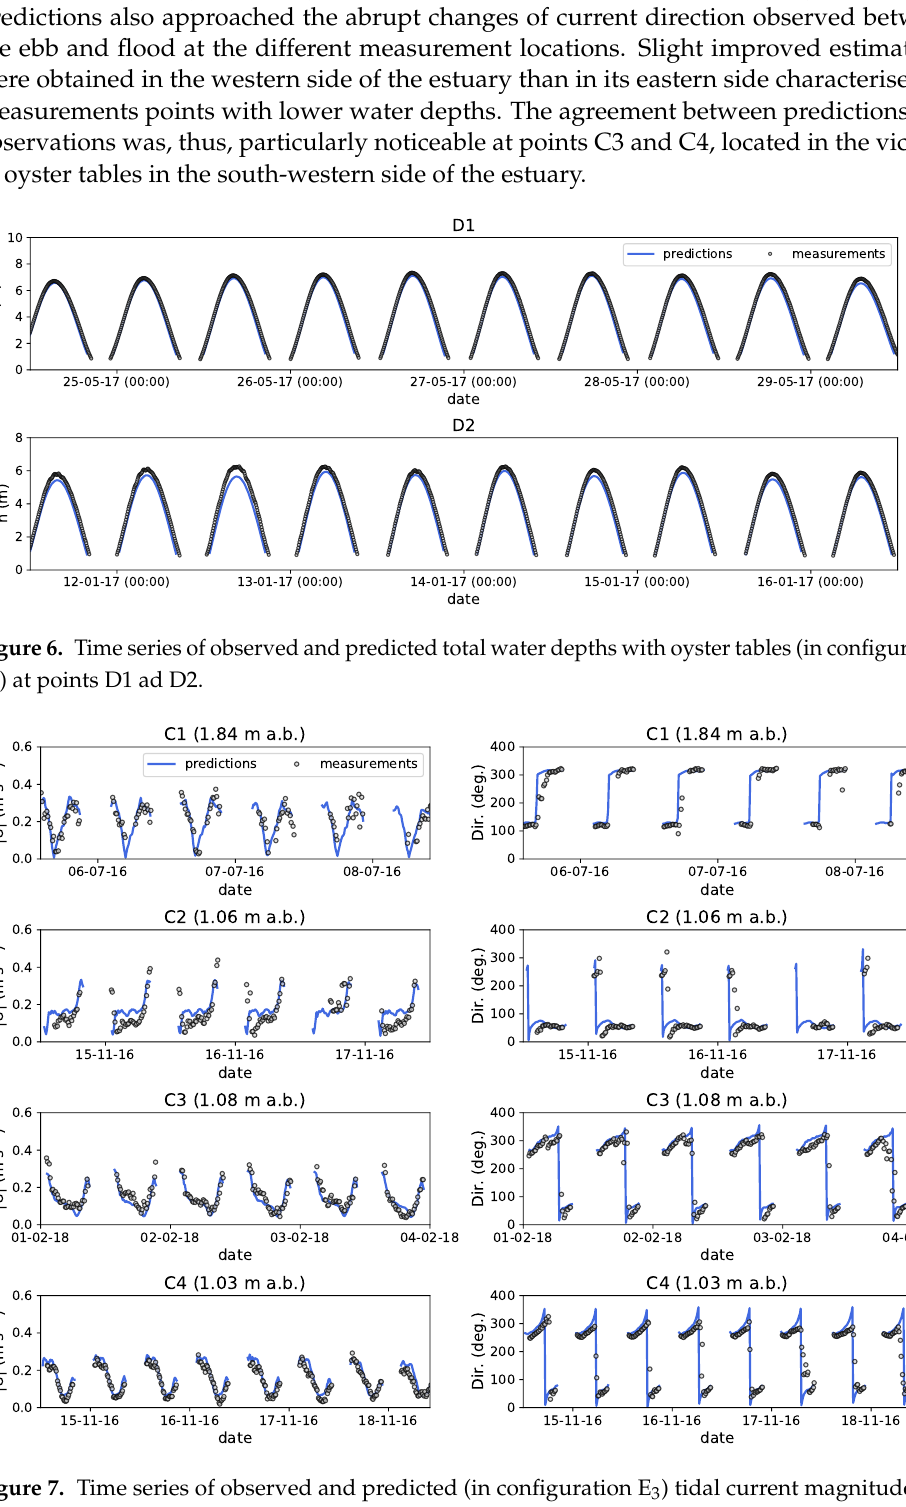
Figure 7. Time series of observed and predicted (in configuration E 3 ) tidal current magnitude and direction (anticlockwise convention from the East) in the western part of the estuary at points C1, C2, C3, and C4 (a.b. for above the bed). Please note also that dates indicated correspond to midnight